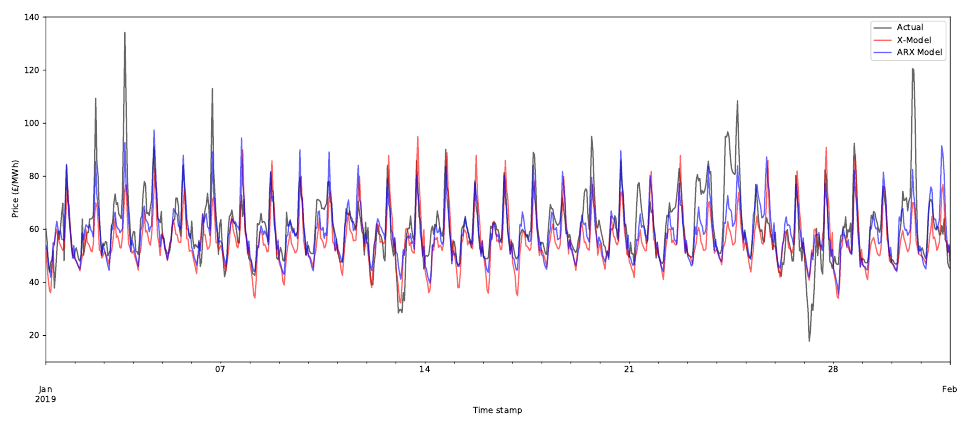
Figure 13. Example of the X-model’s and ARX model’s rolling day-ahead point forecasts for the first month of the test set. Black is the actual, red is the X-model forecast, and blue is the ARX model forecast.